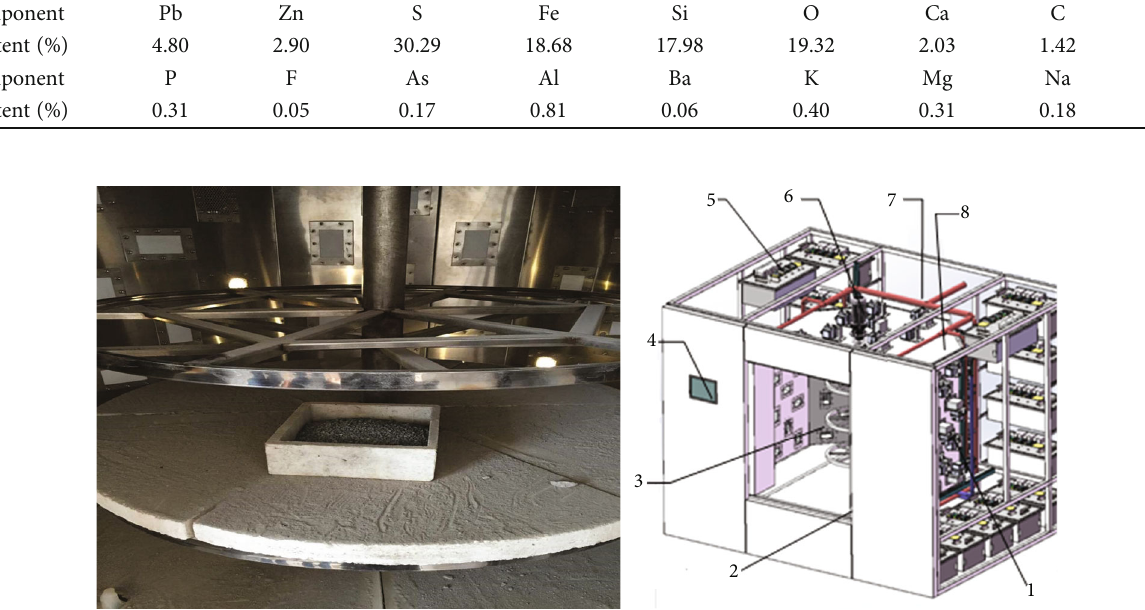
Figure 2: Internal diagram and three-dimensional diagram of the microwave heating